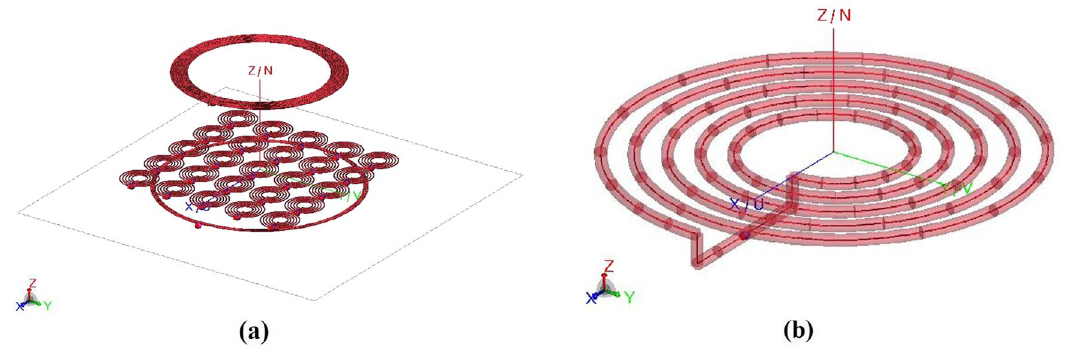
Figure 3. 3D CAD model of: ( a ) the WPT system in the presence of the metasurface; ( b ) the single meta-atom constituting the metasurface.